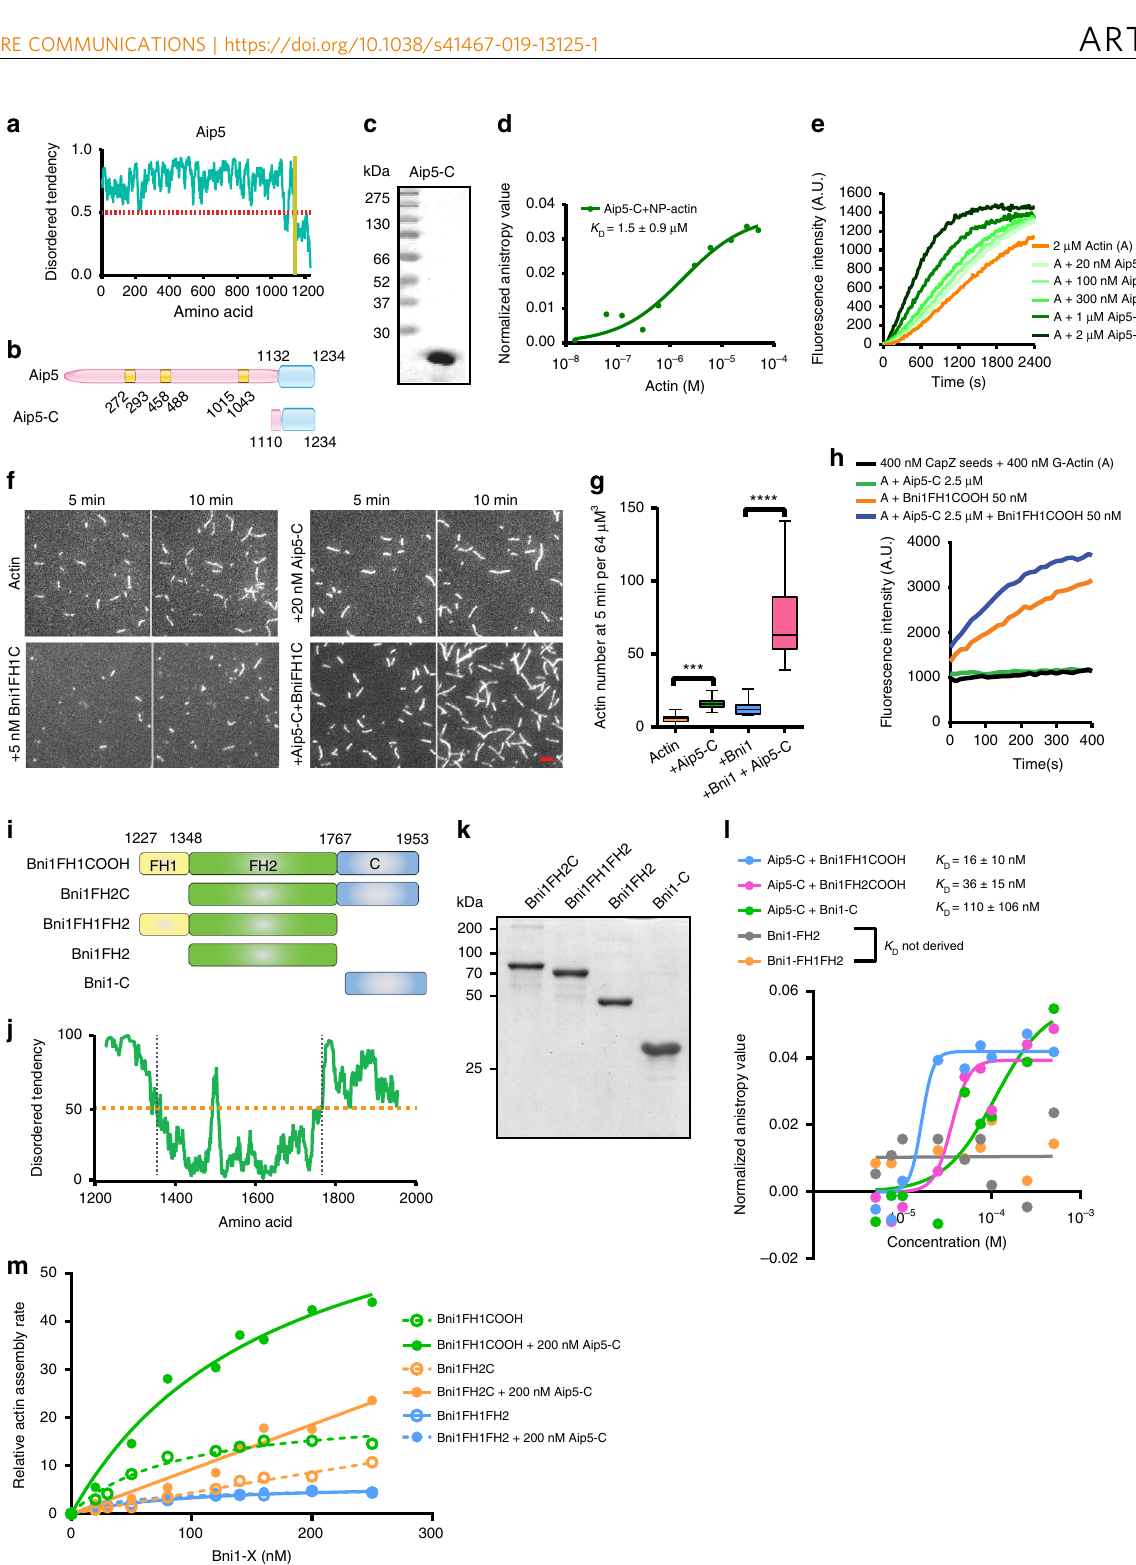
Superposition of protomer A of Aip5-C and Aip5-C-3m structures showed an RMSD of 2.75 Å, which revealed missing electron density for the loop in Aip5-C-3m, indicating increased loop fl exibility (Supplementary Fig. 3f), whereas the superposition of protomer B showed an RMSD of 1.88 Å, which showed more similar conformations inside the well-folded region of Aip5-C (Supplementary Fig. 3g). The Aip5-C-3m still formed a